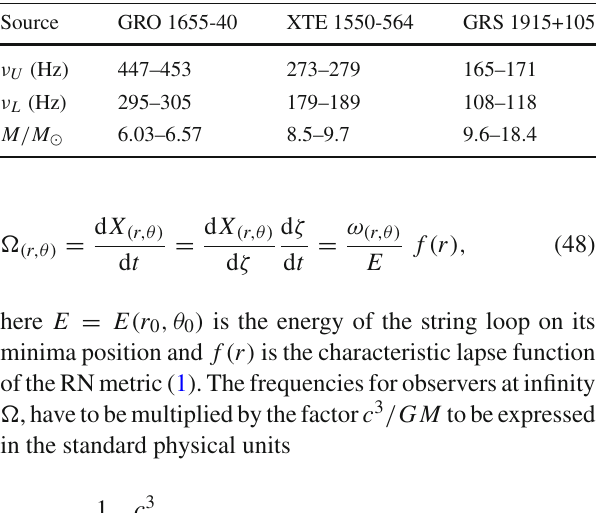
Table 1 Observed twin HF QPOs data for three microquasars, and the restrictions on mass of black holes located in them, based on indepen- dent measurements on the HF QPO